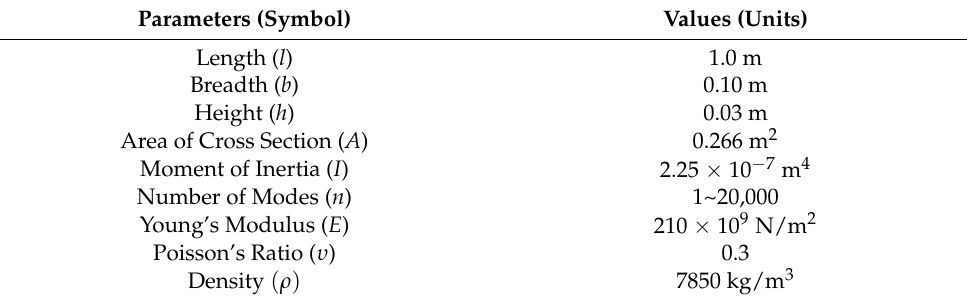
Table 1. Mechanical parameters and properties of the prismatic cantilever